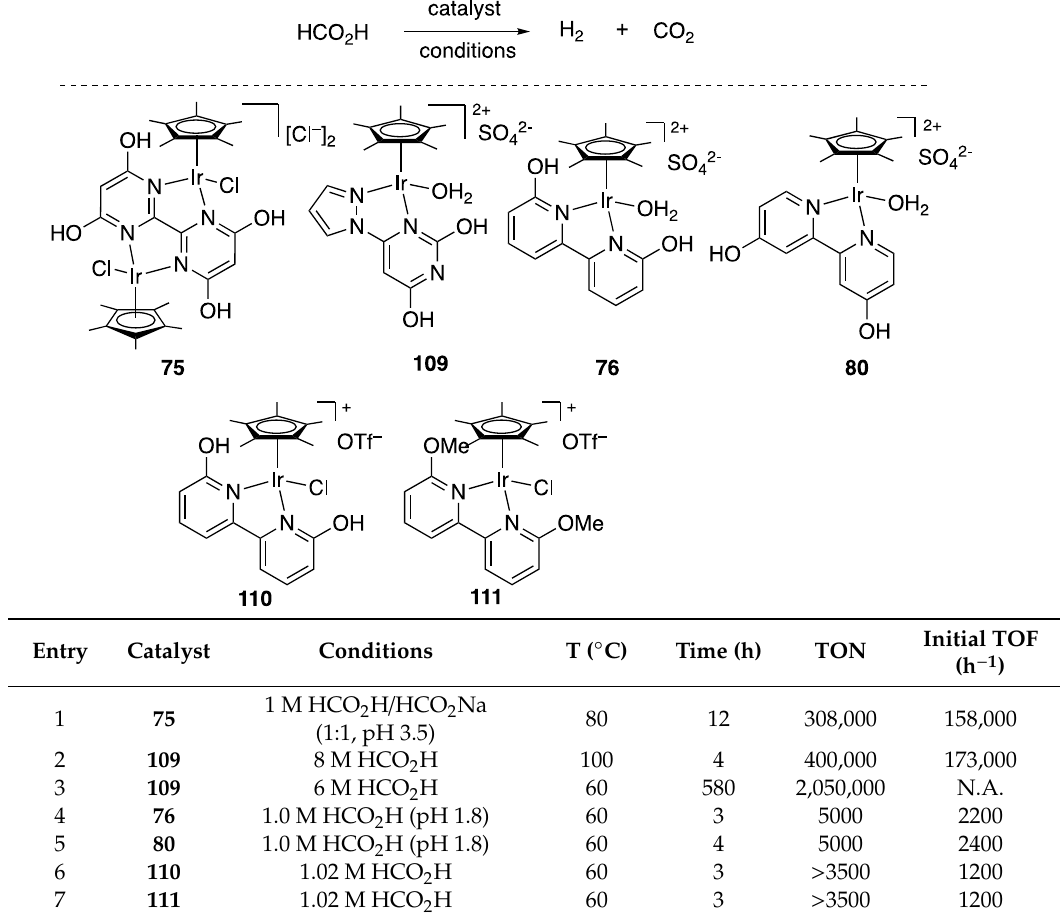
Table 3. Selected Ir catalysts bearing hydroxypyridine-based ligands for the dehydrogenation of formic acid.